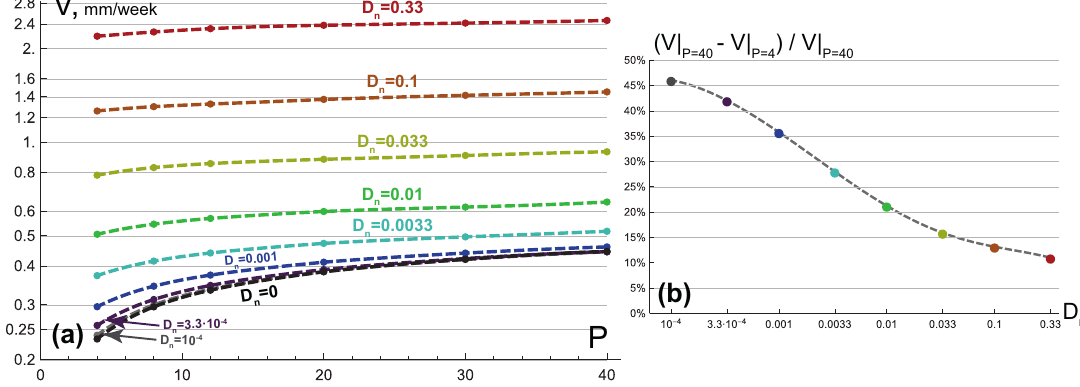
Figure 5. ( a ) The dots denote the values of tumor growth speeds V , obtained numerically in the simulations of Equation (1) with space step h = 0.01 and time step τ = 10 − 4 , under designated values of angiogenesis parameter P and tumor cell motility D n and the values of other parameters taken from the basic set. The dashed lines are interpolations of data points. ( b ) The graph of “maximum angiogenic effect”, based on the data, shown in ( a ), which shows how the tumor growth speed would slow down upon the decrease of angiogenesis parameter P from 40 to four under designated values of D n